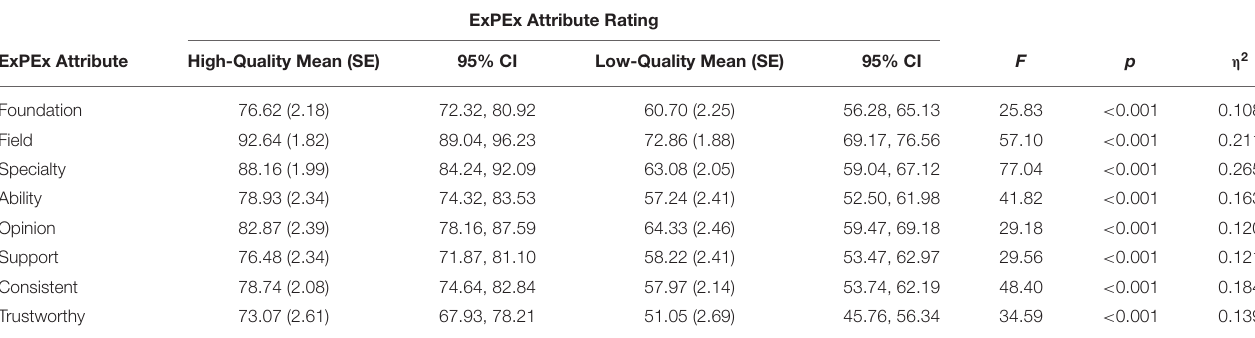
Figure 1 . The mean persuasiveness ratings by condition were: high-quality, high-likeability M = 84.5 (SD = 11): high-quality, low-likability M = 72.8 (SD = 24.2); low-quality, high-likeability M = 62.7 (SD = 24.4); low-quality, low-likeability M = 47.9 (SD = 32). A two-way ANOVA showed a significant main effect of evidence quality [ F (1, 214) = 50.76, p < 0.001, η p 2 = 0.192] and a significant main effect of likeability [ F (1, 214) = 16.39, p < 0.001, η p 2 = 0.071]. The high-quality expert